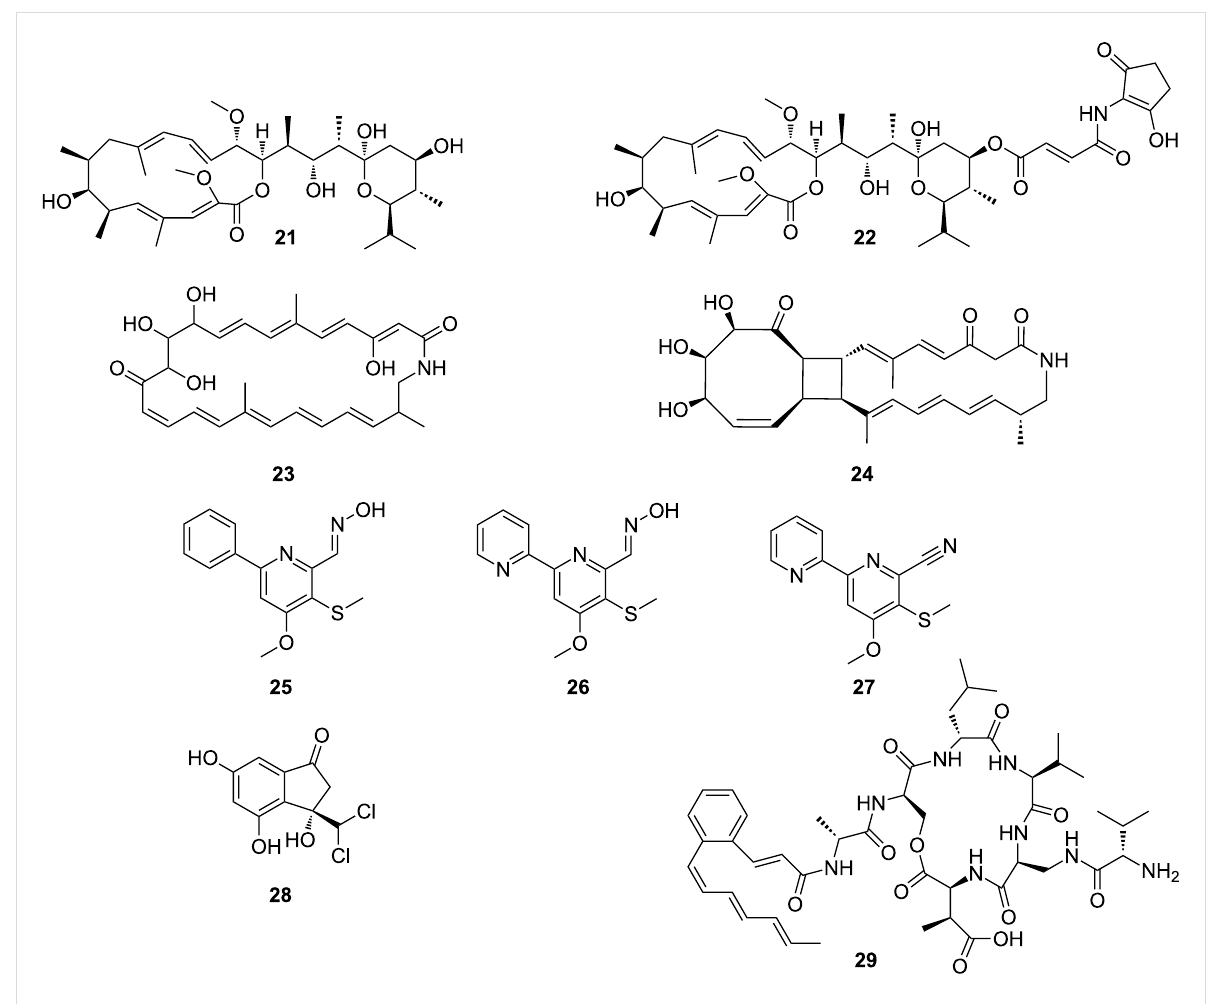
Figure 7: Secondary metabolites from bacterial mutualists of solitary insects. Bafilomycin A1 ( 21 ), bafilomycin B1 ( 22 ), sceliphrolactam ( 23 ), triparti- lactam ( 24 ), coprismycin A ( 25 ), collismycin A ( 26 ), dipyridine SF2738D ( 27 ), tripartin ( 28 ), and coprisamide A ( 29